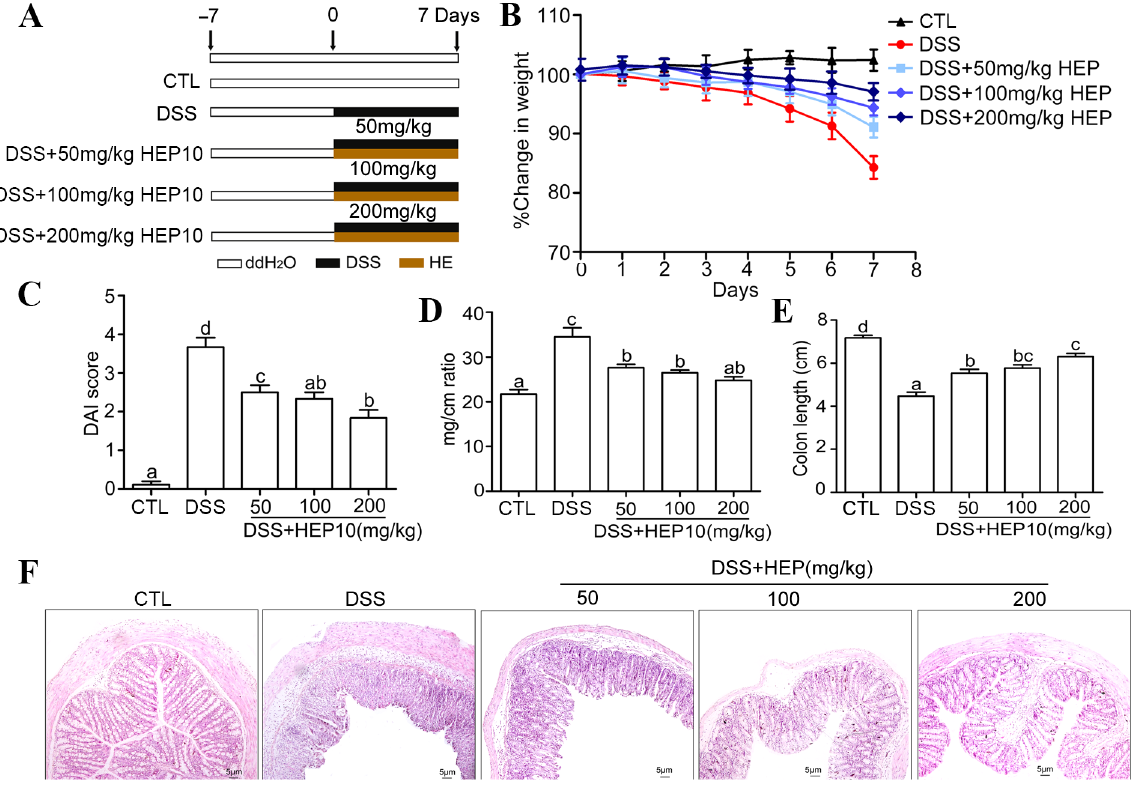
Figure 4. Administration of HEP10 attenuated mice’s colitis induced by 2% DSS. ( A ) Experimental protocol for the treatment of HEP in DSS-induced colitis in male C57BL/6J mice ( n = 5 per group). ( B ) The changes of body weight during the disease progression. ( C ) DAI score, ( D ) colon mg/cm ratio, ( E ) colon length, and ( F ) representative image of H&E staining of colons tissue from each group. Scale bar: 5 µm. The data is presented as means ± SD ( n = 5). Different alphabetic letters refer to significant differences ( p < 0.05, two sided).